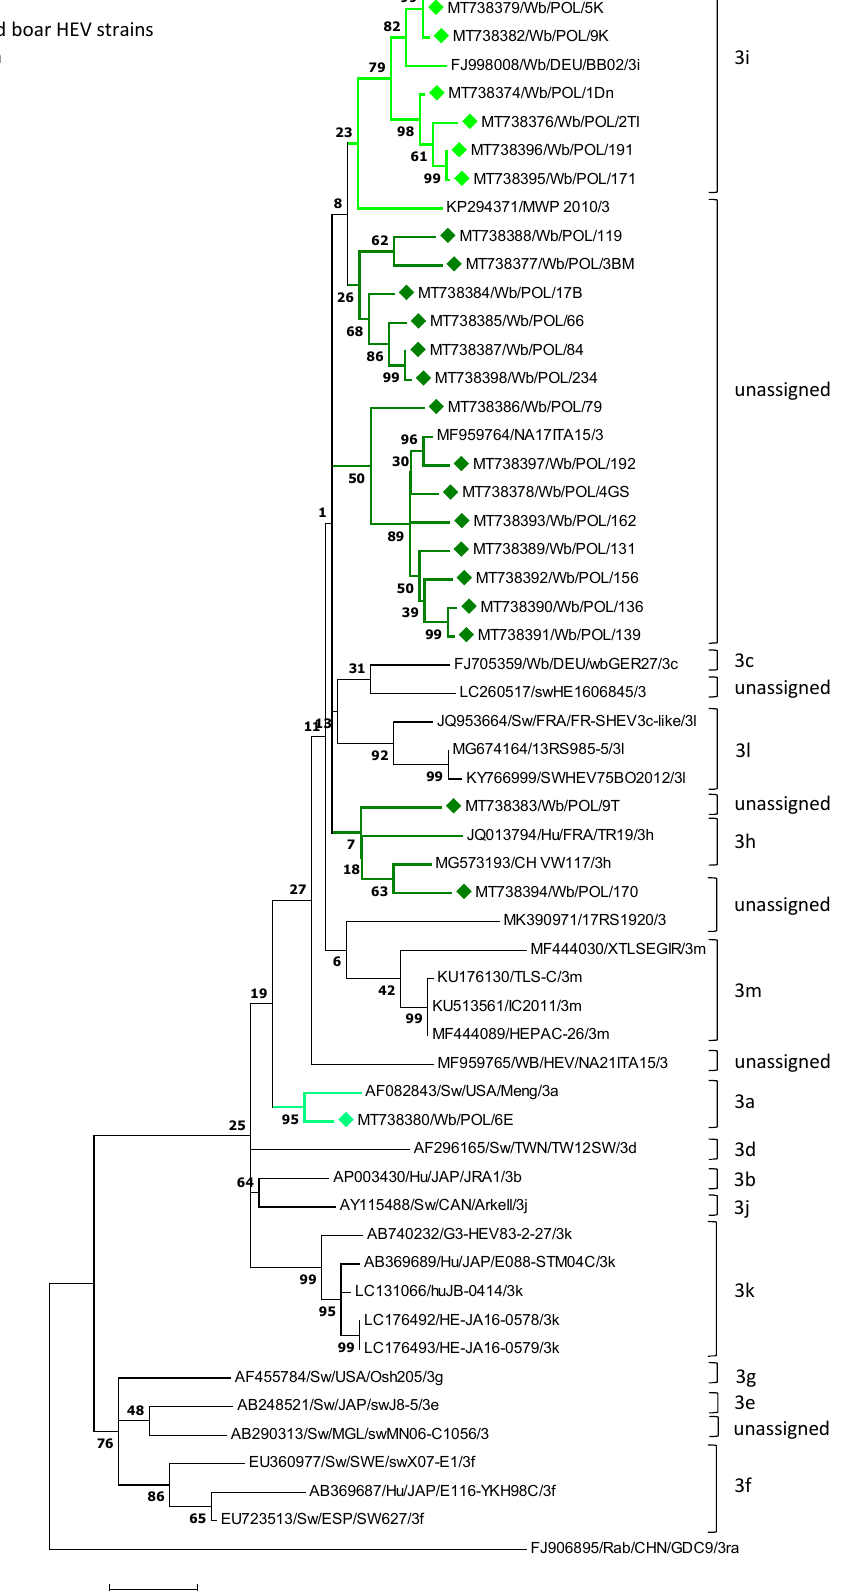
Figure 1. The phylogenetic tree constructed using the nucleotide sequences of the ORF2 genome fragment (348 bp) of HEV-3 strains detected in humans and animals.